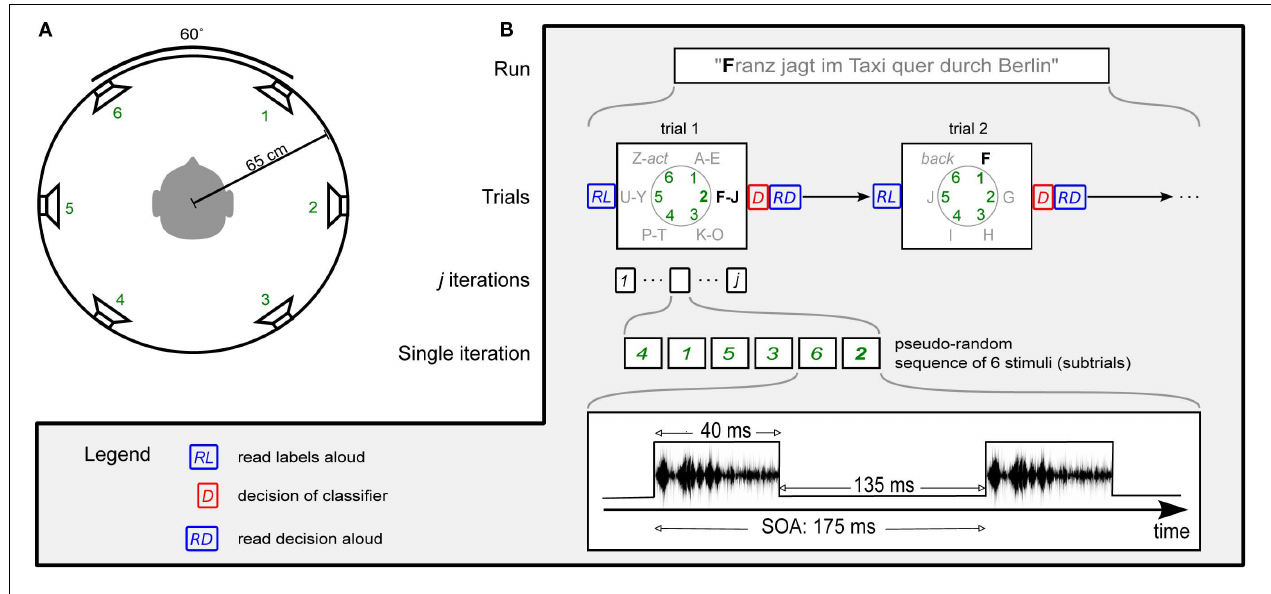
experimental protocol in the online phase. In Session 1, the number of iterations j was set to 15. For Session 2, j was determined by the dynamic stopping method. No labels were read aloud (RL) in Session